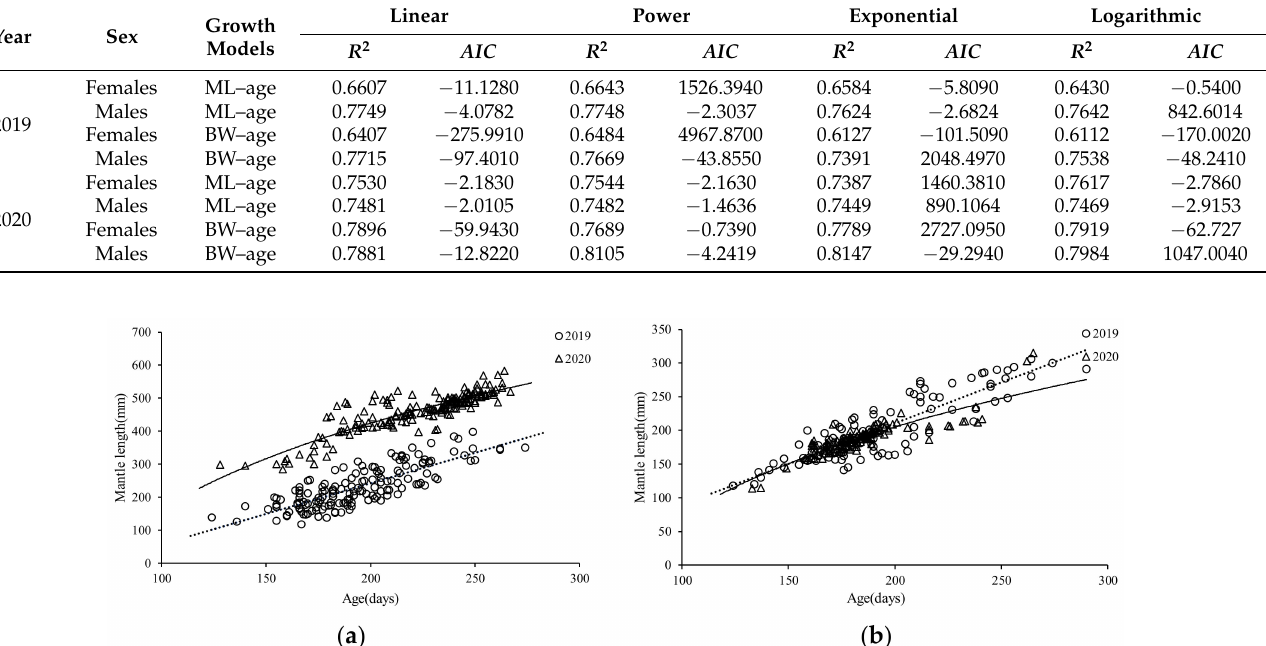
Table 1. Parameters of the linear, power, exponential, and logarithmic growth models fitted to the ML–age and BW–age relationships of the S. oualaniensis samples.